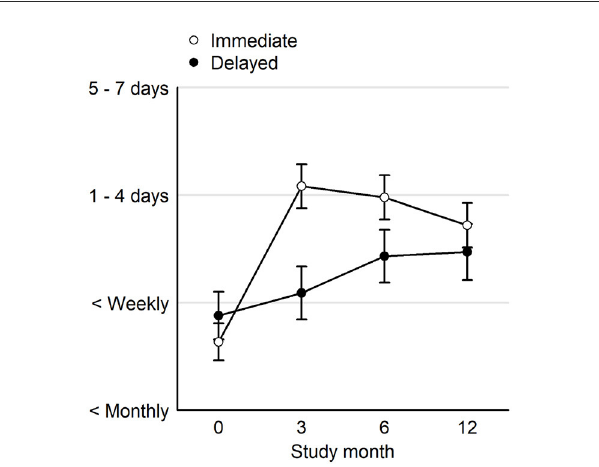
FIGURE1 Averages and 95% uncertainty intervals over the 4-point ordinal rating for cannabis use at the start of the clinical trial (Month 0), the end of the clinical trial (Month 3), and the follow up period (Months 6 and 12). Immediate, immediate card acquisition group; Delayed, delayed card acquisition group.